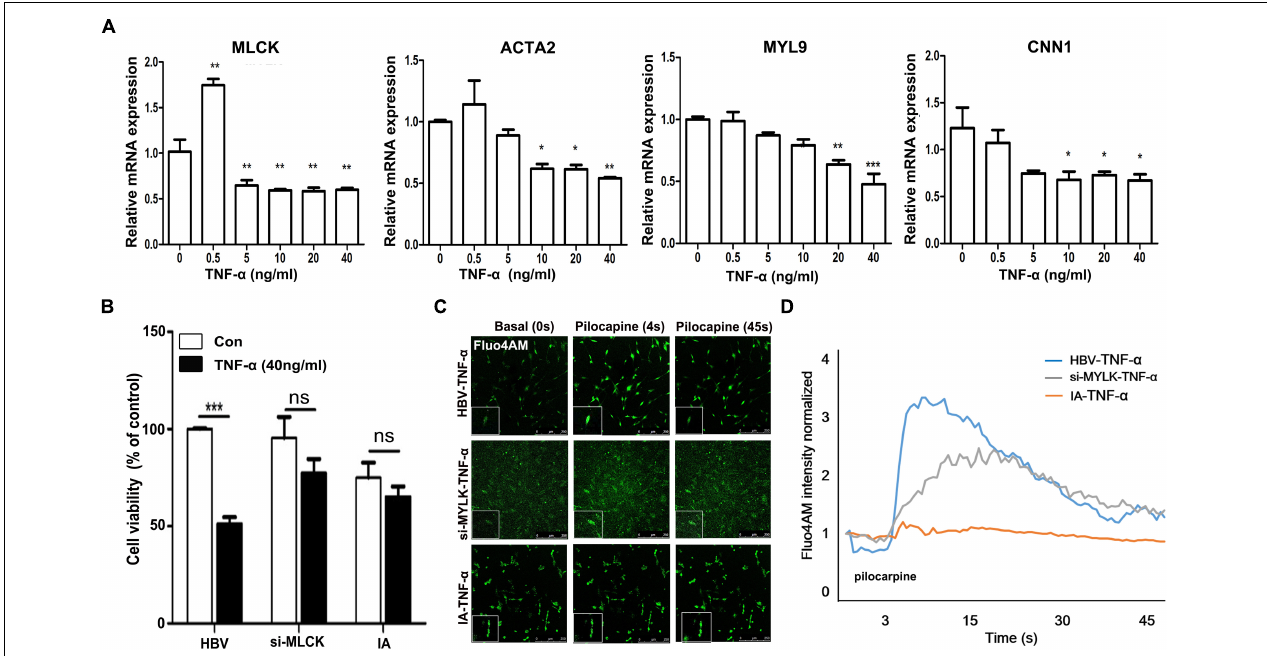
FIGURE 4 | Genetically downregulated MLCK affects cell function more with the stimulation of TNF- α . (A) HBVSMCs were treated with a gradient dose of TNF- α and the levels of the mature SMC markers MLCK, ACTA2, MYL9, and CNN1 were detected. (B) All three kinds of cells were detected for cell viability by cck-8. (C) Ca 2 + flux measured by loading Fluo-4 AM. (D) Quantification of contractility measured as the fluorescence change in the cell surface area of HBVSMCs, si- mlck SMCs, and IASMCs. The relative mRNA level was normalized to the control. Data are presented as the means ± SD, ∗ p < 0.05, ∗∗ p < 0.01, ∗∗∗ p < 0.001. HBVSMC, human brain vascular smooth muscle cell; IASMC, intracranial aneurysm smooth muscle cell; si- mlck SMC, HBVSMCs with interfered mlck